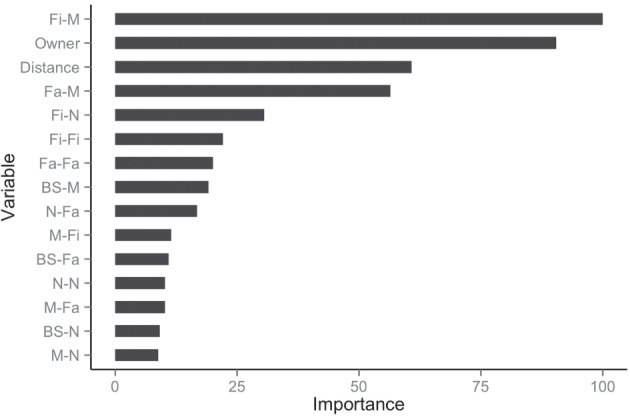
Rank of the 15 most important variables for network prediction using the balanced dataset.